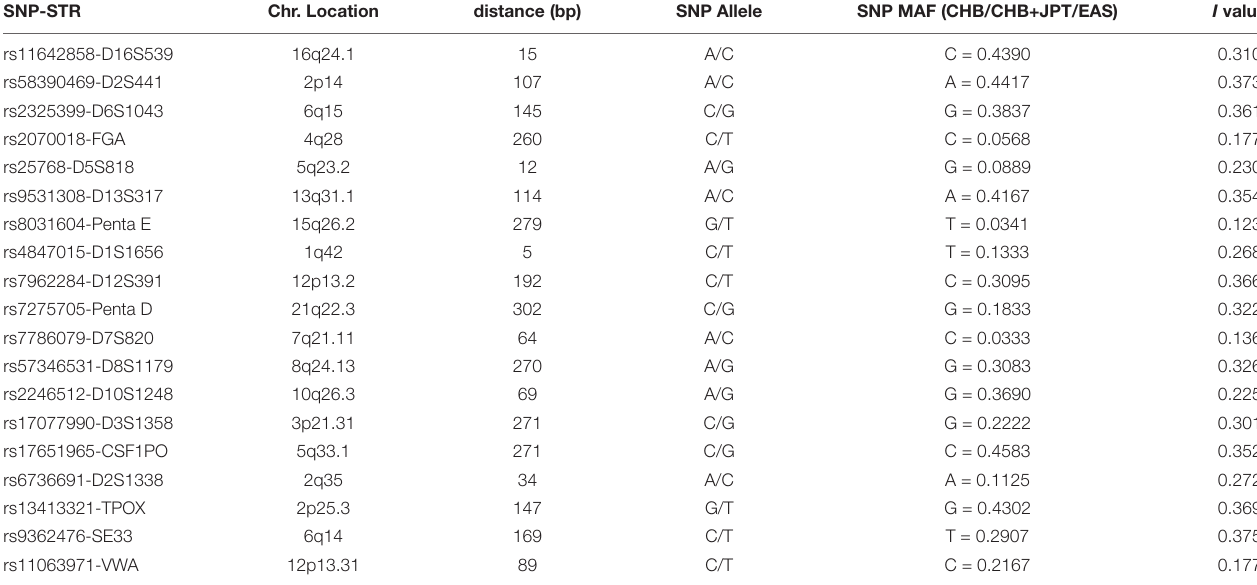
TABLE 1 | Information about the 19 SNP-STR loci. SNP-STR Chr.